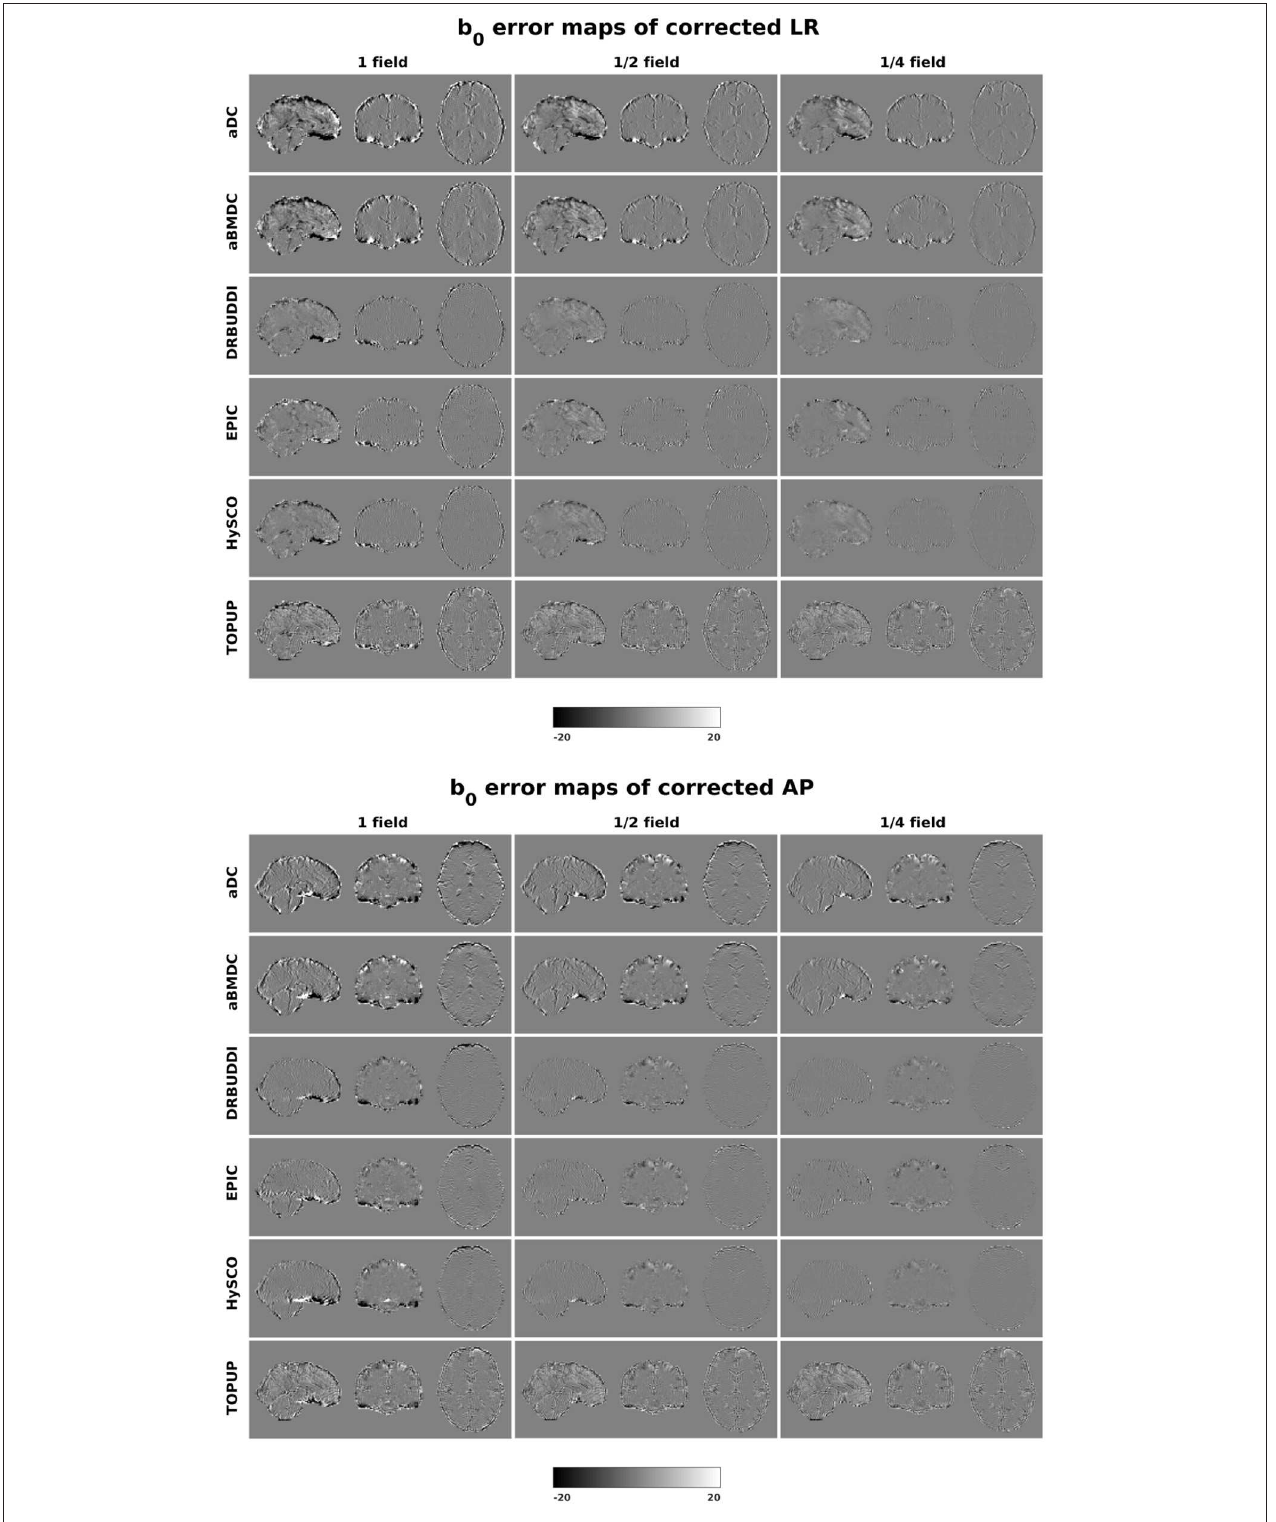
FIGURE 4 | b 0 error maps for simulated HCP Subject 100206 using the six methods. Three levels of susceptibility distortion were simulated. Correction was carried out for LRRL (left) and APPA (right) pairs, respectively. Three levels of susceptibility distortion were simulated.